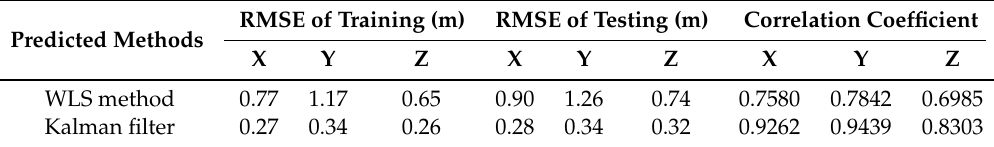
Table 3. Prediction errors and correlation coefficient of the two